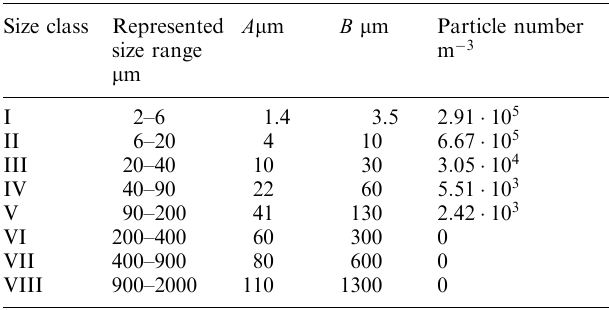
Fig. 6. Modelled size distributions (steps) for natural cirrus ( solid ) and contrails (